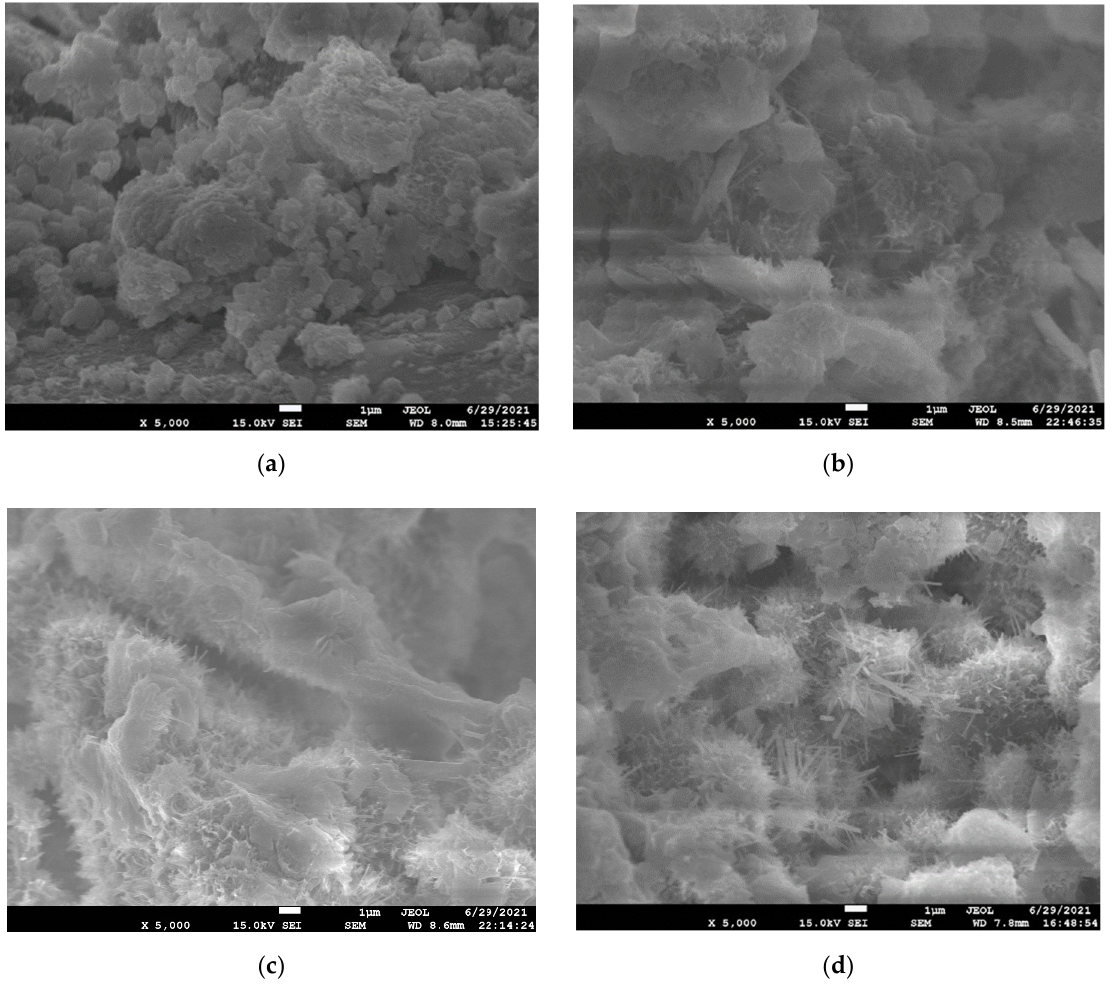
Figure 12. SEM patterns of CSTB in 3 d (( a ) SC = 68%; ( b ) SC = 76%) and 7 d (( c ) SC = 68%; ( d ) SC = 76%) under TCR = 4.